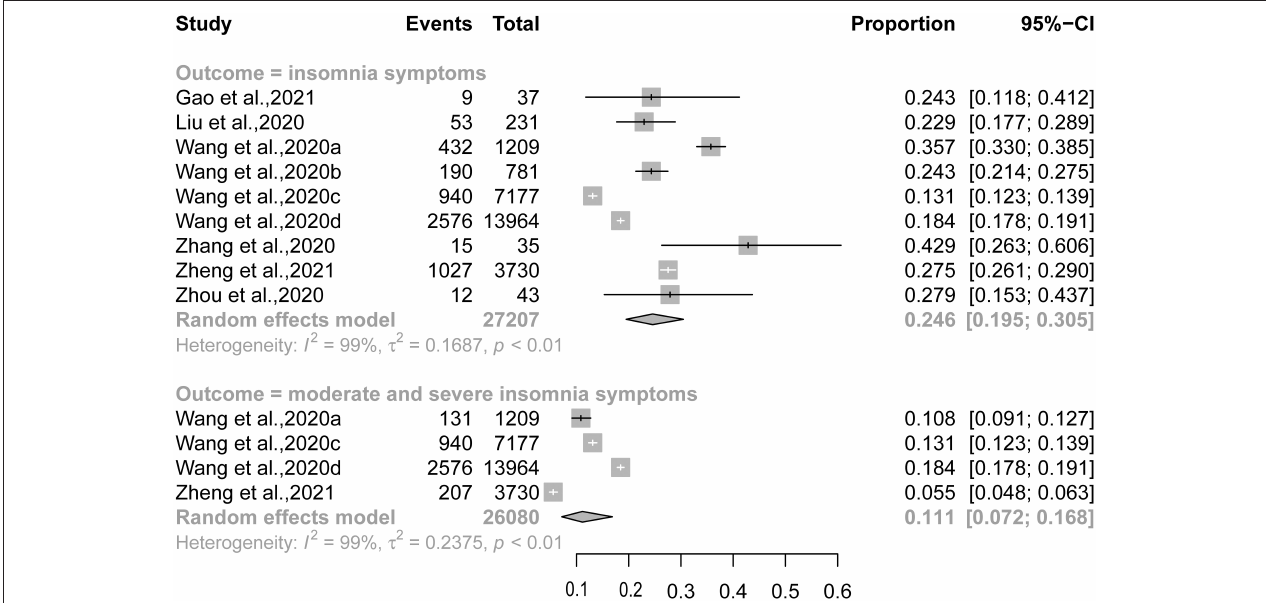
FIGURE 2 | Forest plot of the prevalence of insomnia symptoms and moderate and severe insomnia symptoms.